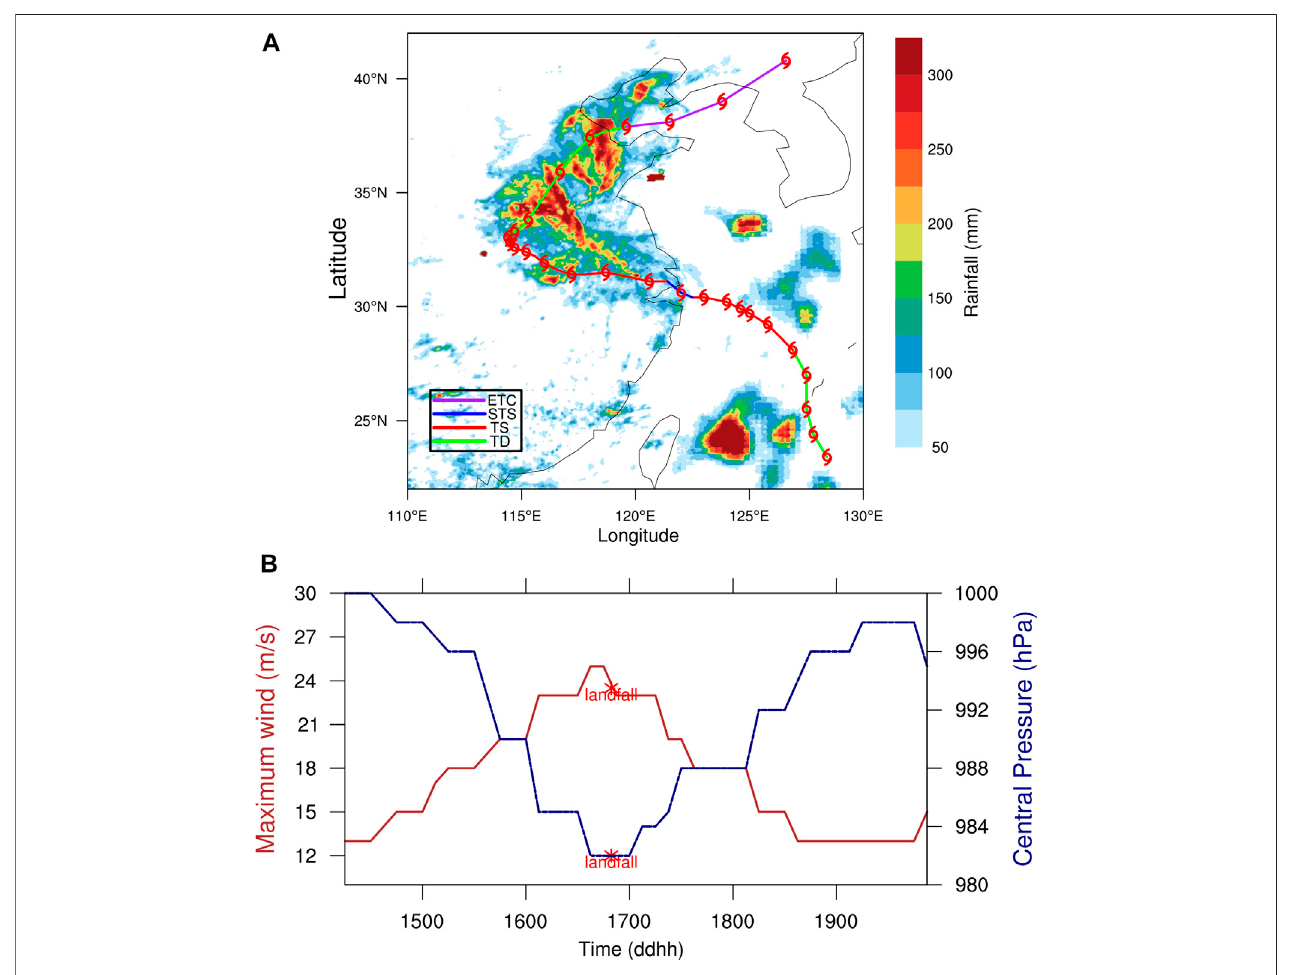
FIGURE1|(A) Observedstormtrack(solidline)andaccumulatedtotalrainfall(shading,mm). (B) Observedevolutionofthecentralpressure(bluepolyline,hPa)and maximum 10-m height wind speed (red polyline, m/s) from 0600 UTC 14 (1406, in the form of ddhh on the x -axis) August to 1800 UTC 20 (2018, in the form of ddhh on the x -axis) August